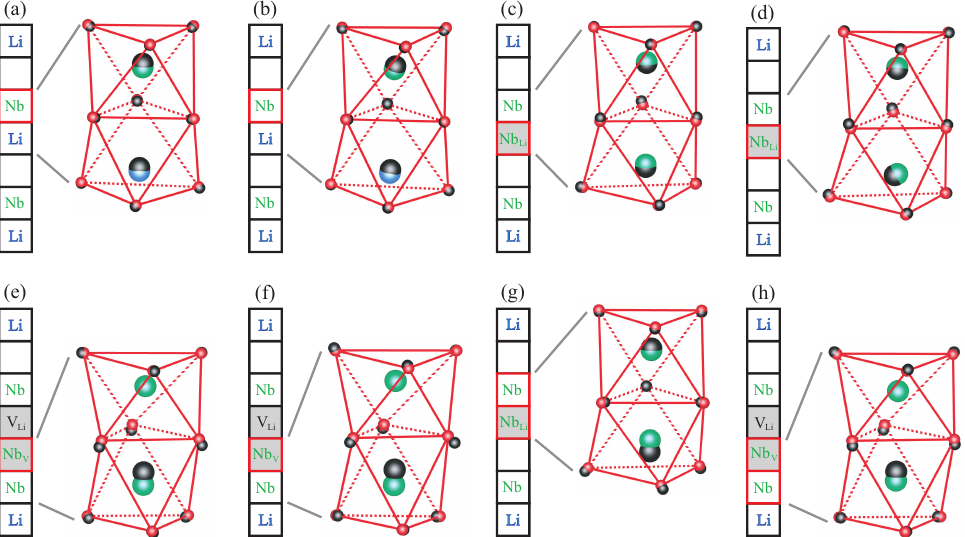
Figure 3. Crystal structure in the vicinity of the free polaron ( a , b ), the bound polaron at a Nb Li antisite defect ( c , d ) or a Nb V –V Li defect pair ( e , f ), and the bipolaron at Nb Li ( g ) or Nb V –V Li ( h ). Subfigures ( b , d , f ) refer to tilted configurations with broken trigonal symmetry, all other structures exhibit axial symmetry. Black balls indicate atomic positions in stoichiometric LN without polarons, while blue, green, and red balls denote lithium, niobium, and oxygen atoms in the relaxed structures, respectively. Note that ( e , f , h ) show a different segment of the crystal than the other